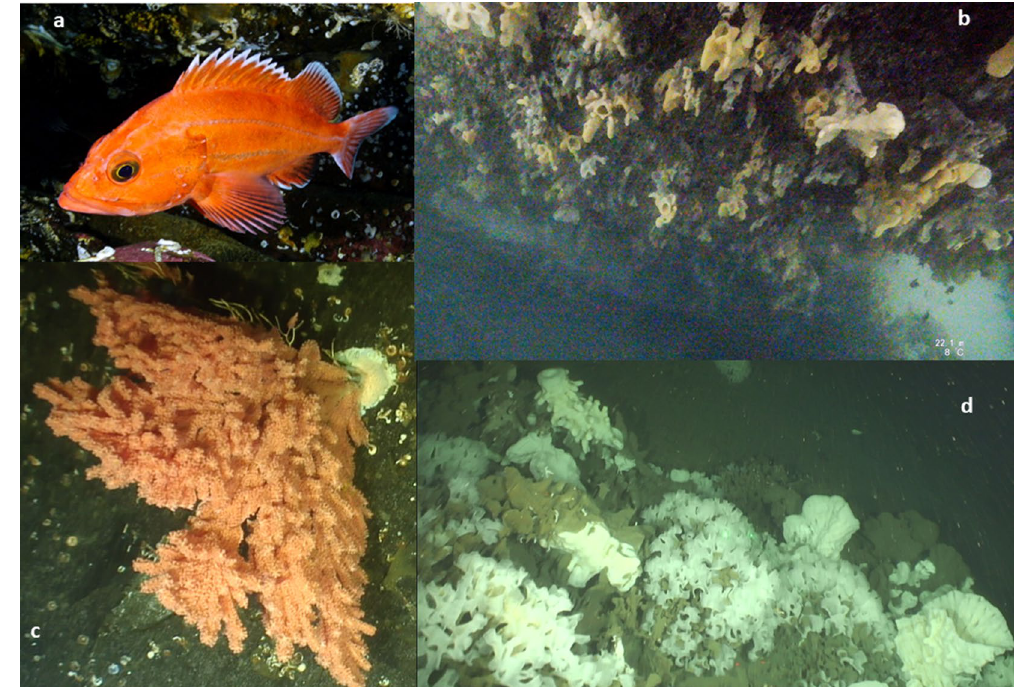
Figure 4. Examples from each taxonomic group observed during the study: ( a ) a Sebastidae, yelloweye rockfish ( Sebastes ruberrimus ); ( b ) large-bodied sponge garden on rocky wall ; ( c ) a structural coal, Primnoa pacifica ; ( d ) large-bodied sponge bioherm reef. (All images obtained by the authors during data